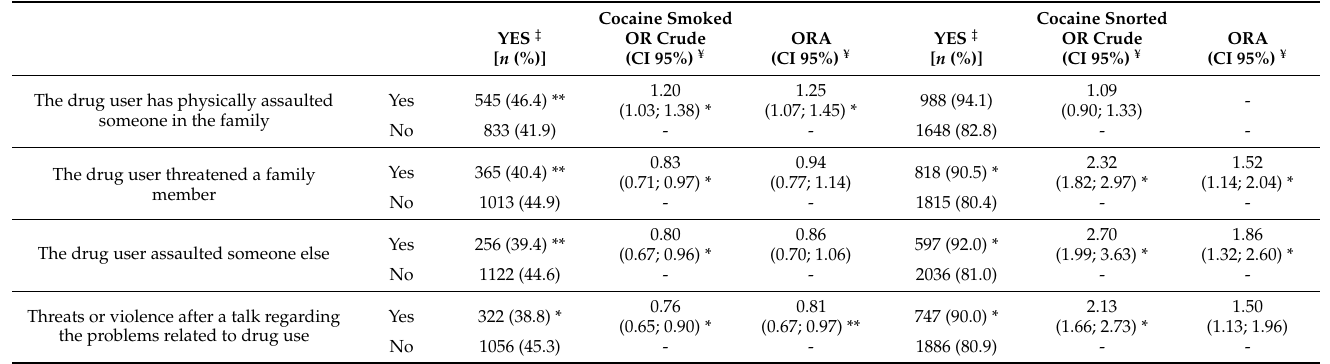
Table 4. Physical and interpersonal domestic violence reported by